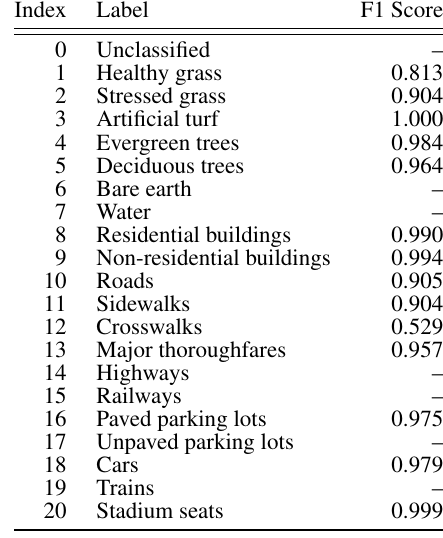
Table 1. Classes of the DFC 2018 along with the F1